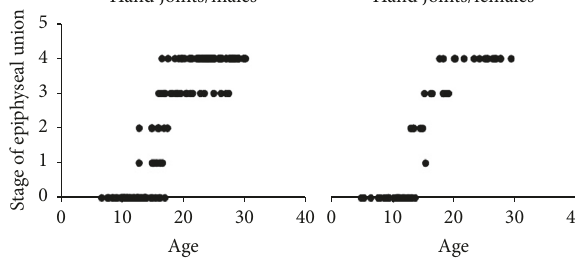
Figure 6: The graphical presentation of our sample range of age in the different epiphyseal union stages in hand